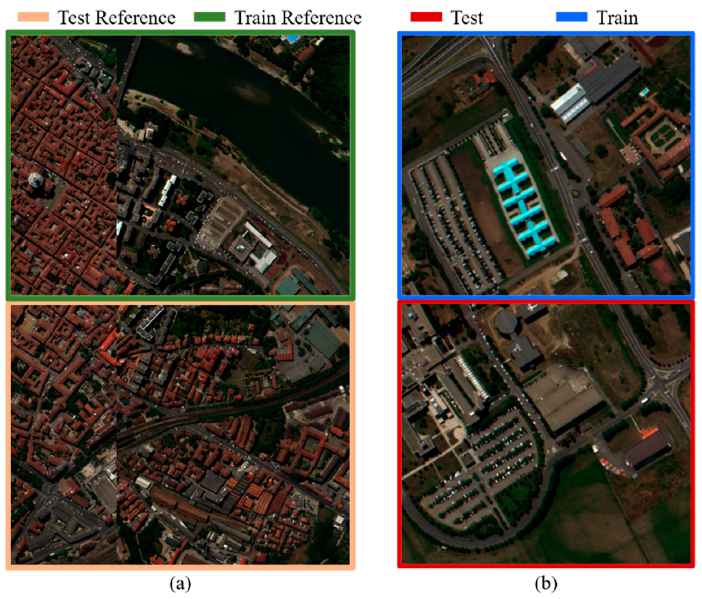
Figure 4. Original Pavia Centre and Pavia University data sets: ( a ) Pavia Centre; ( b ) Pavia University. The border color indicates the purpose of the image.